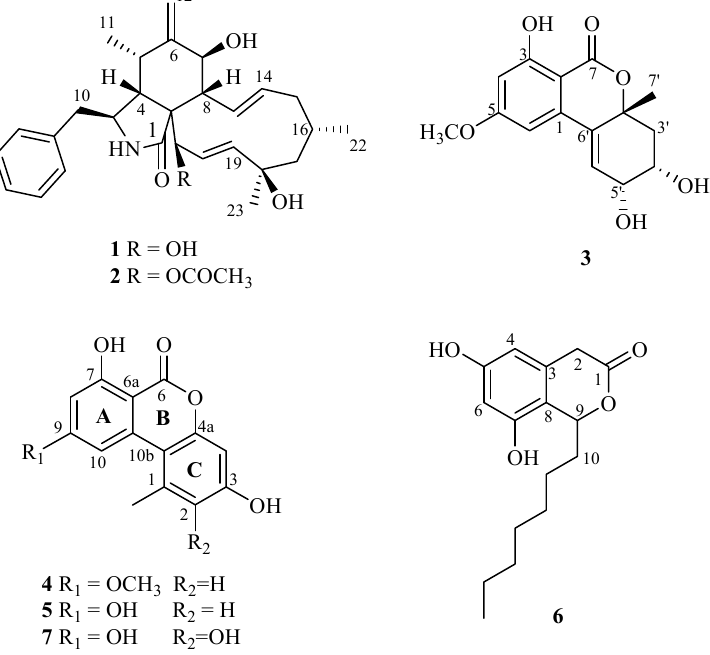
Figure 1. Chemical structures of 1 – 7 produced by Phomopsis